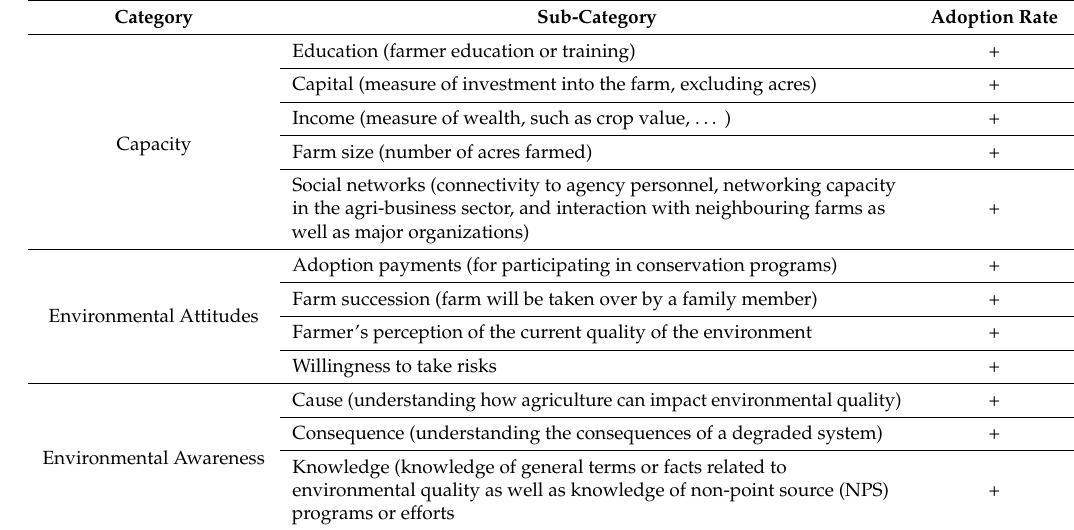
Table 3. Social factors that lead to positive adoption rates according to Prokopy et al. [65]. Category Sub-Category Adoption Rate Education (farmer education or training) + Capital (measure of investment into the farm, excluding acres) + Income (measure of wealth, such as crop value, ... ) + Capacity Farm size (number of acres farmed) + Social networks (connectivity to agency personnel, networking capacity in the agri-business sector, and interaction with neighbouring farms as well as major organizations)